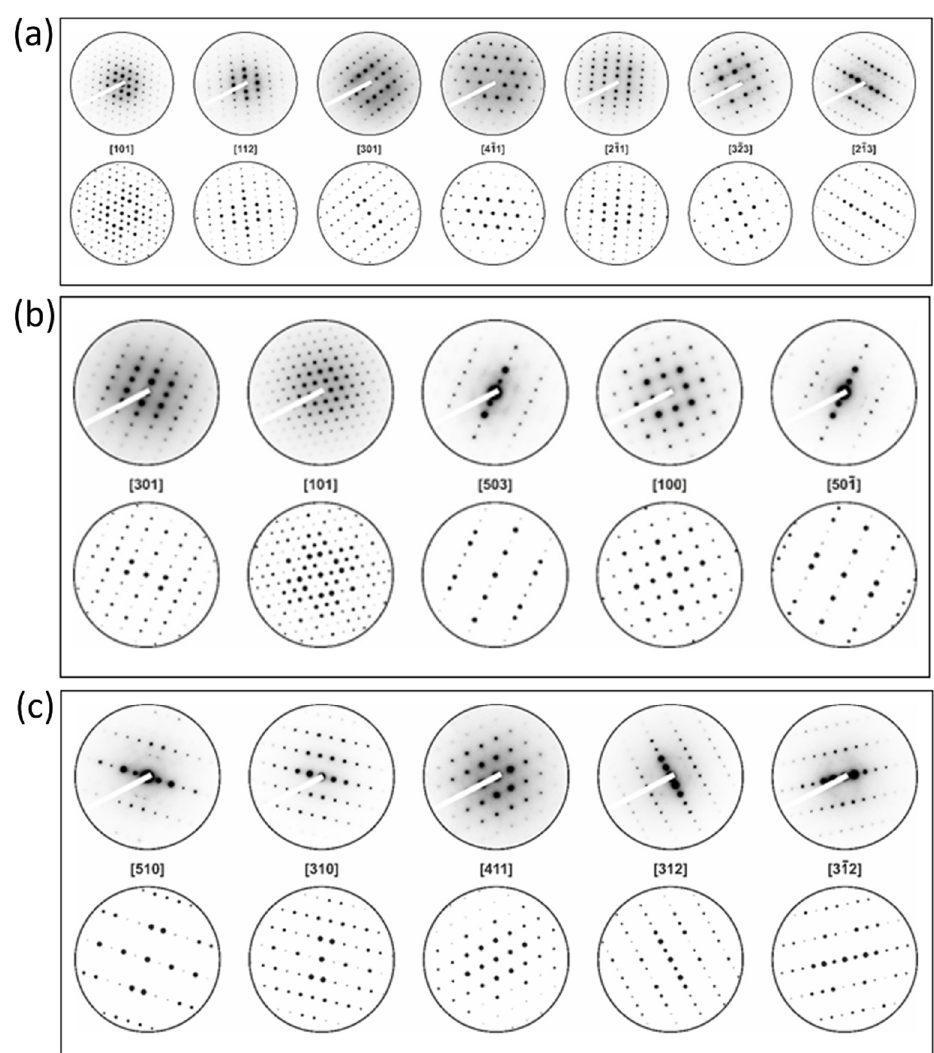
Figure 10. SAED analysis of ( a ) CaNi 2 ( b,c ) Ca x Mg 1 − x Ni 2 ( x = 0.5).